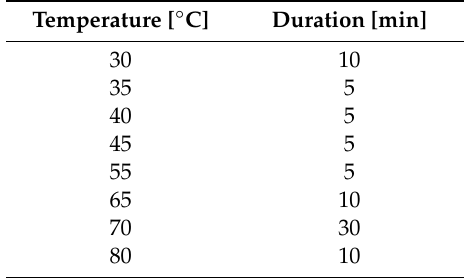
Table 1. Heating scheme for KcsA monomer